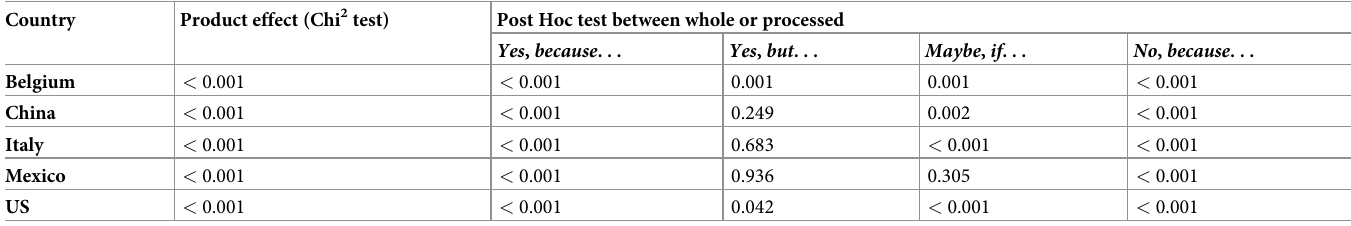
Table 3. Effects ( P value) of the two mealworm products (whole or processed) on the acceptance towards inclusion in the diet. Country Product effect (Chi 2 test) Post Hoc test between whole or processed Yes , because . . . Yes , but . . . Maybe , if . . . No , because . .